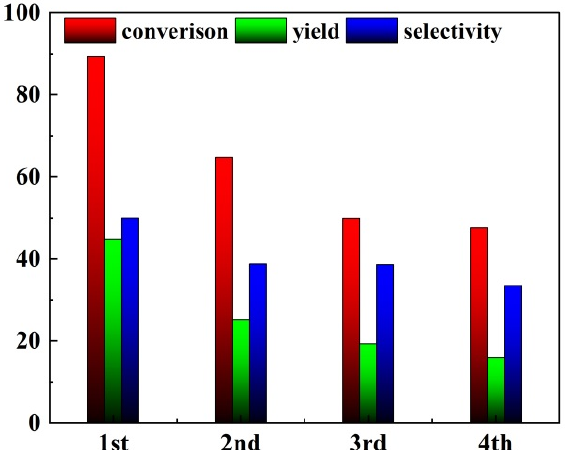
Figure 12. Recyclability test of UiO-66-NO 2 -25 for HMF production from glucose showing percentage conversion, yield and selectivity.